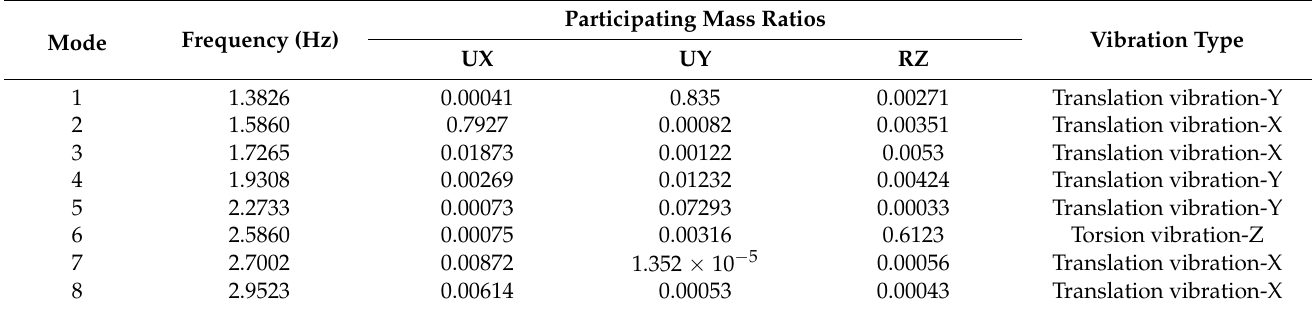
Table 4. Modal analysis results of the MR damped